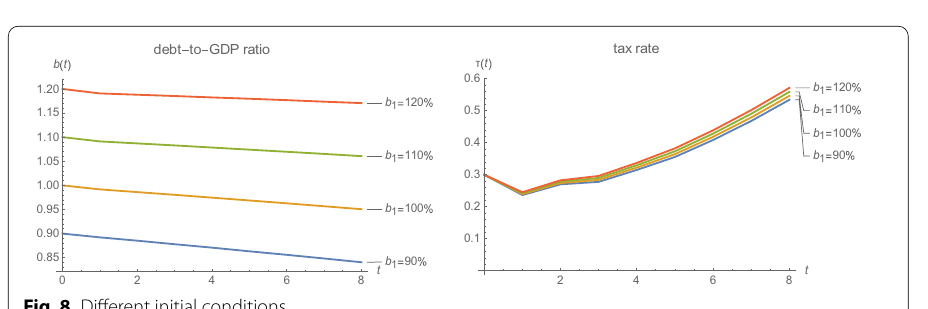
Fig. 8 Different initial